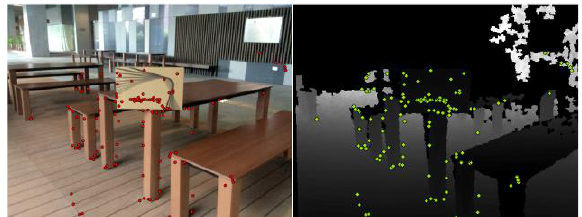
Figure 4. (Left) Feature matches from an RGB image. (Right) Feature matches on the corresponding depth